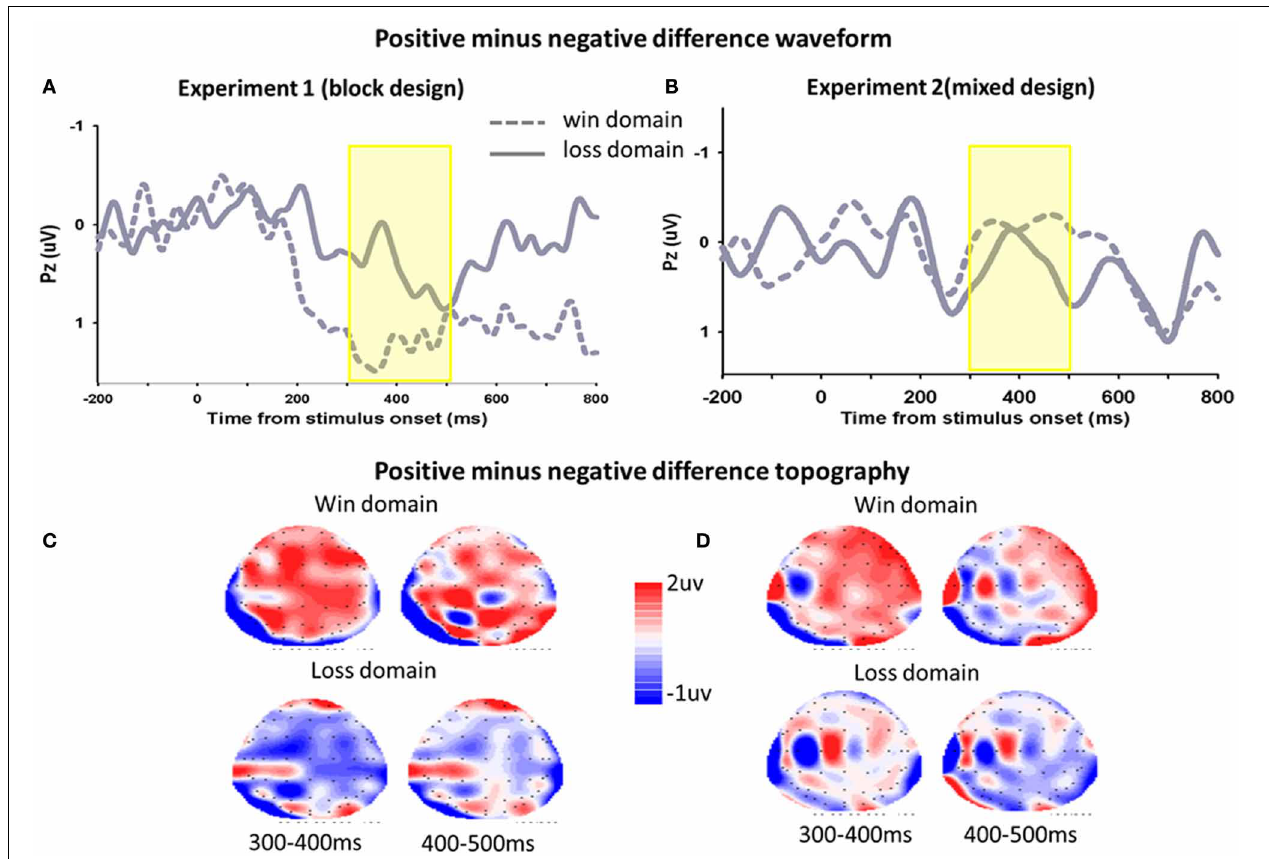
FIGURE 5 | The ERP difference waveforms and topograph (P300). In Experiment 1 (A) and Experiment 2 (B) , difference waveforms (positive minus negative) in the win domain and the loss domain were shown. The corresponding topographical maps (300–500ms, 100ms increment) were shown (C,D)